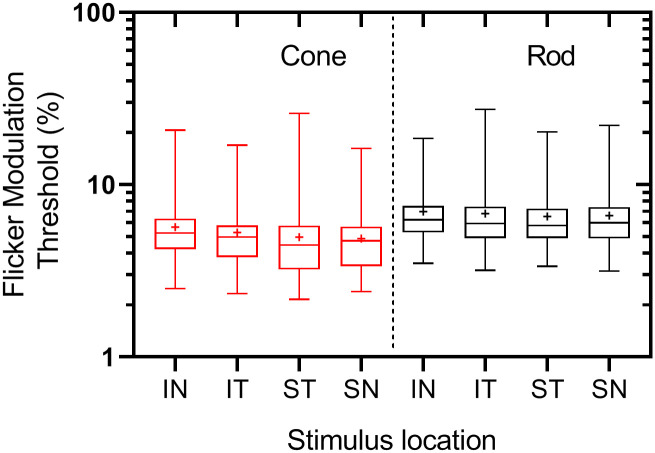
Box plot of cone and rod (FMT) obtained in the four parafoveal locations (inferonasal—IN, inferotemporal -IT, superotemporal—ST, superonasal- SN) across all participants.Box plot showing the median, first quartile, third quartile, minimum and maximum FMT for each test location. Note that rod thresholds are slightly higher than cone thresholds. The plus symbol indicates the mean of each group.